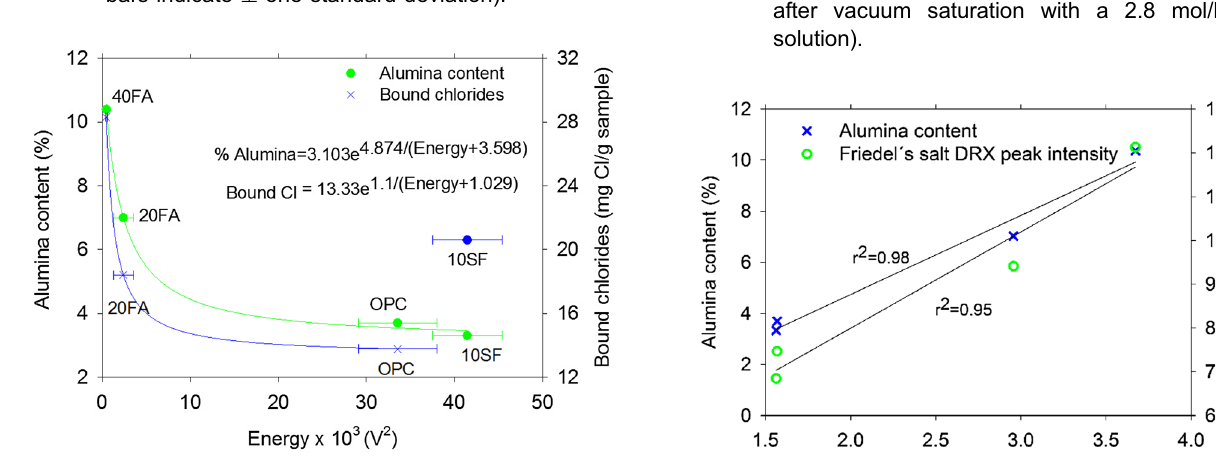
Fig. 11 Energy of the ultrasonic response of pastes vacuum saturated with a 2.8 mol/L NaCl solutions (the error bars indicate ± one standard deviation).